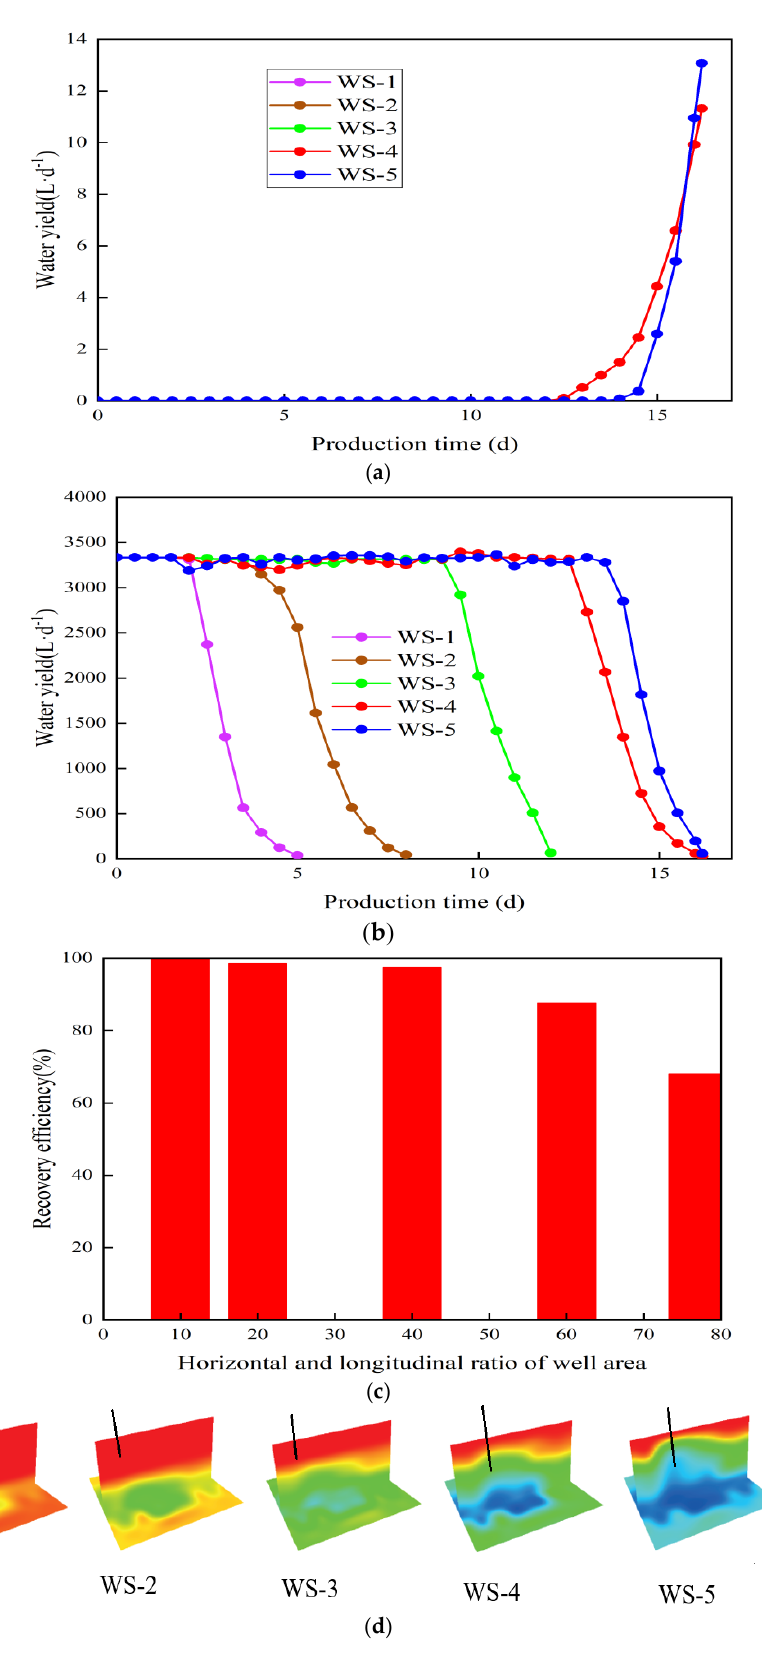
Figure 8. Experimental results of the physical simulation of water invasion in a homogeneous bottom-water gas reservoir: ( a ) water yield relationship curve, ( b ) gas production relationship curve, ( c ) recovery factor relationship curve and ( d ) 3D profile diagram.